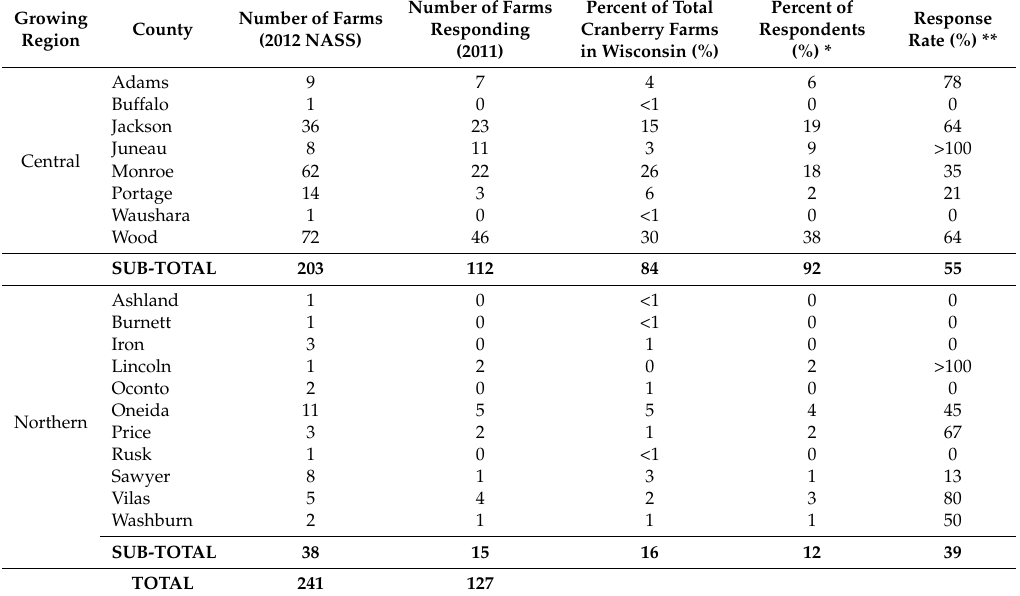
Table 1. Summary of farm numbers and number of responding farms by county including the total number of cranberry farms per county, the number of surveys returned from each county, the percentage of cranberry farms found in each county, the percentage of respondents from each county (number of respondents per county/total surveys returned), and the response rate by county (surveys returned/number of